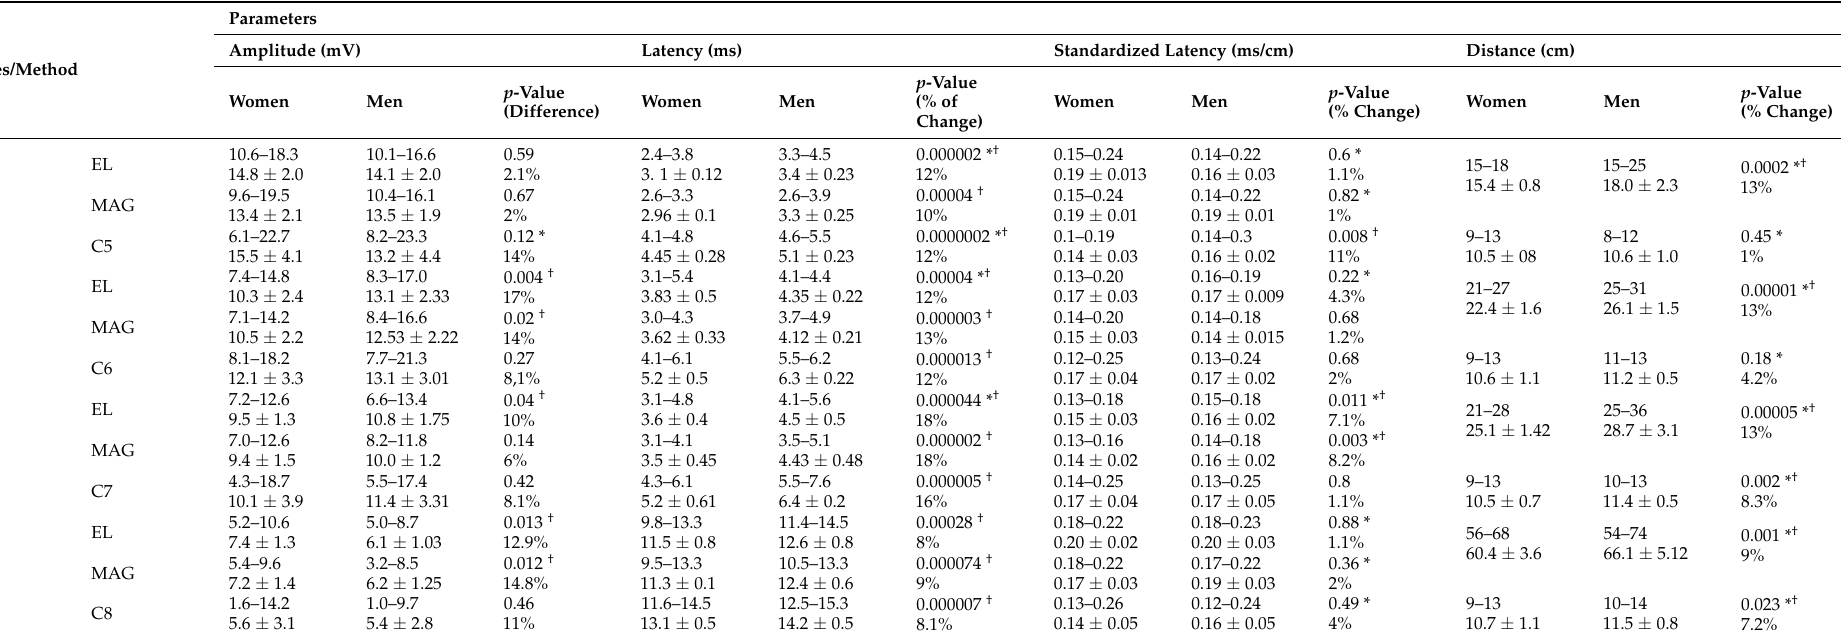
Table 3. Comparison of results of neurophysiological tests between women ( n = 42) and men ( n = 42) using electric and magnetic stimulation at Erb’s point and magnetic stimulation of cervical roots from C5 to C8. Ranges, means, and standard deviations are presented. † Significant p -values <